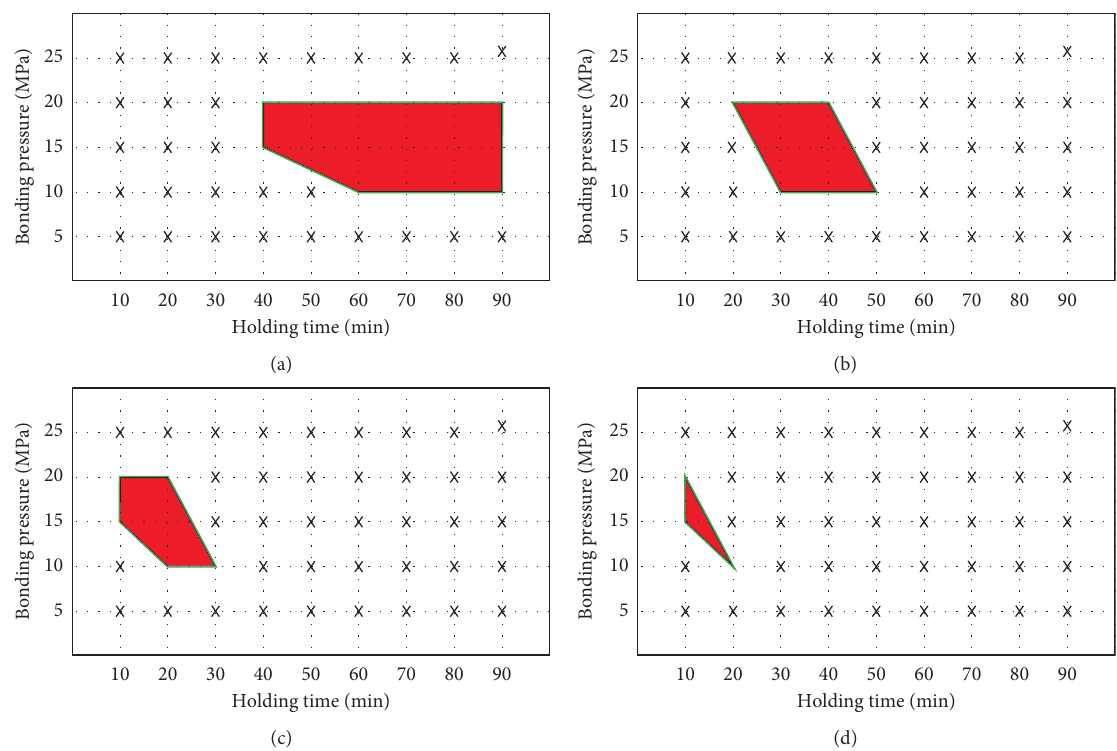
Figure 7: Pressure-time (P-t) diagrams. (a) 750 ° C. (b) 800 ° C. (c) 850 ° C. (d) 900 °